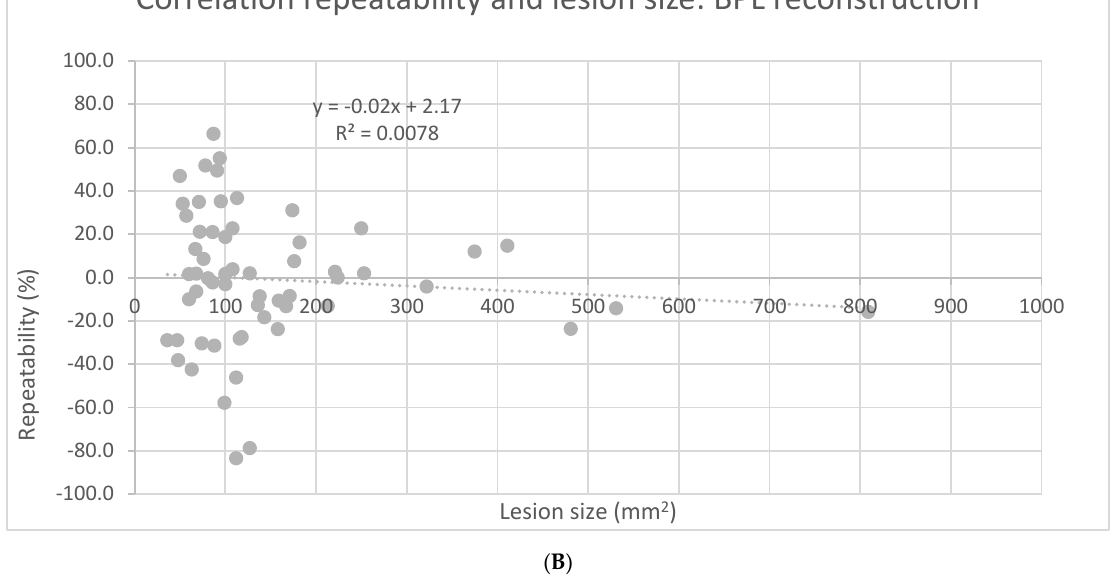
Figure 2. Correlation between SUVmax repeatability and lesion size for standard OSEM ( A ) and BPL reconstruction ( B ). Tumor absolute SUVmax was higher in BPL reconstructions than in standard OSEM reconstructions for all lesions (data not shown). The relative increase in measured SUVmax in the BPL reconstructions (as compared to standard OSEM reconstruction) was dependent on lesion size. Smaller lesions (lesion area < 200 mm 2 ) showed a significant larger increase of SUVmax as compared to larger lesions (lesion area > 200 mm 2 ): 44.3% ± 4.6% versus 25.5% ± 42.2% for the test scans ( p = 0.004) and 43.5% ± 3.9% versus 18.6% ± 3.1% for the retest scans ( p < 0.001), respectively. See Table 2.